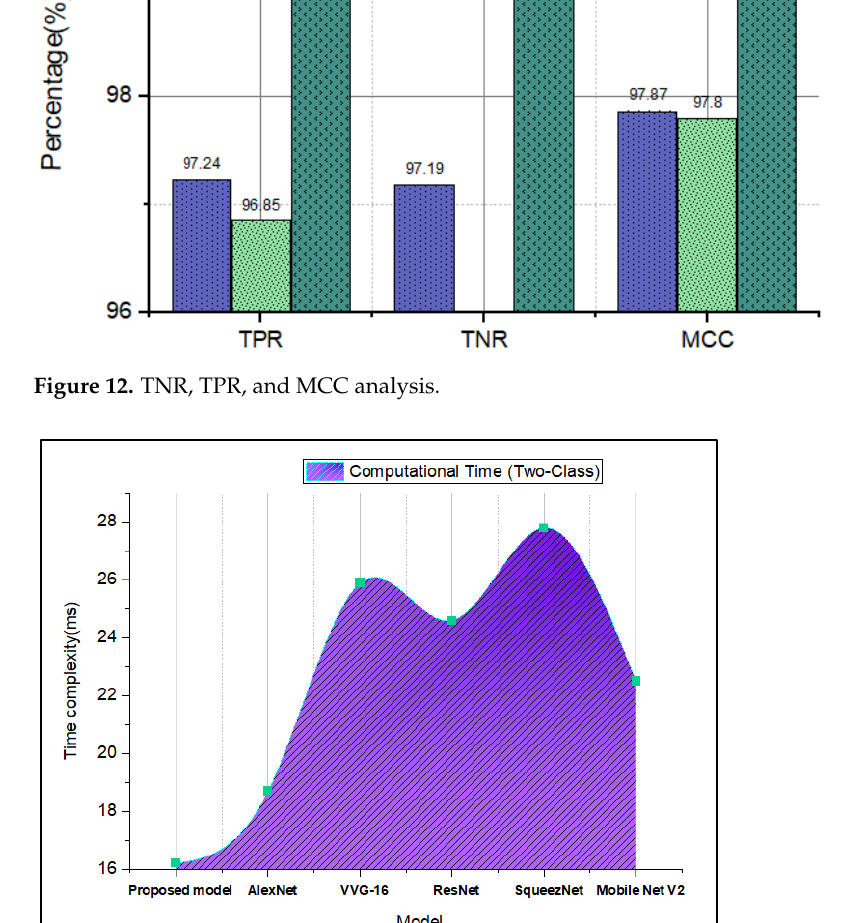
Figure 12. TNR, TPR, and MCC